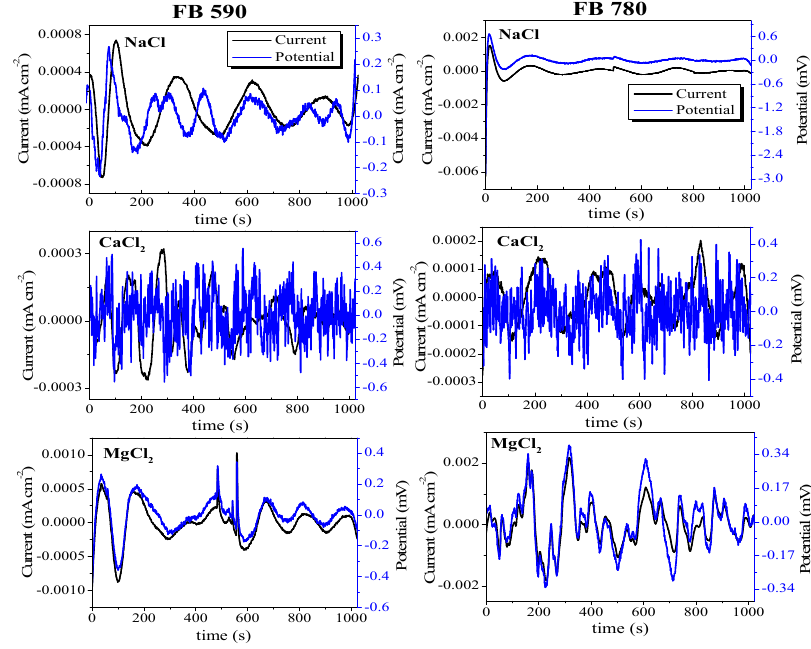
Figure 4. Removing DC trend from the electrochemical current and potential noise for FB590 and FB780 steels in different solutions.